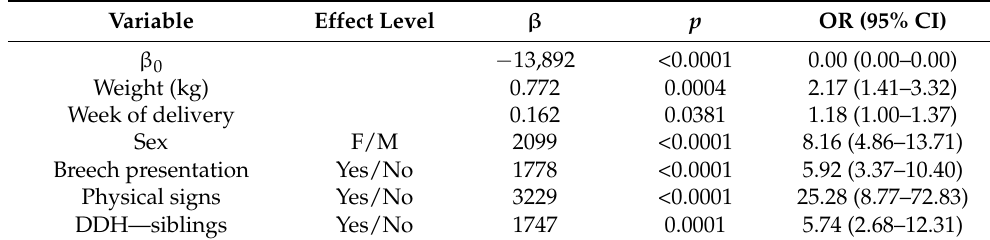
Table 5. Multivariate logistic regression model to predict the incidence of DDH in children.